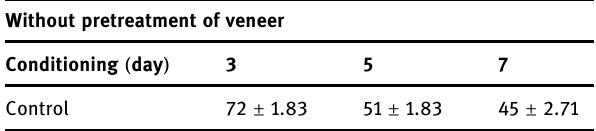
Table 4: Percentage of delamination of